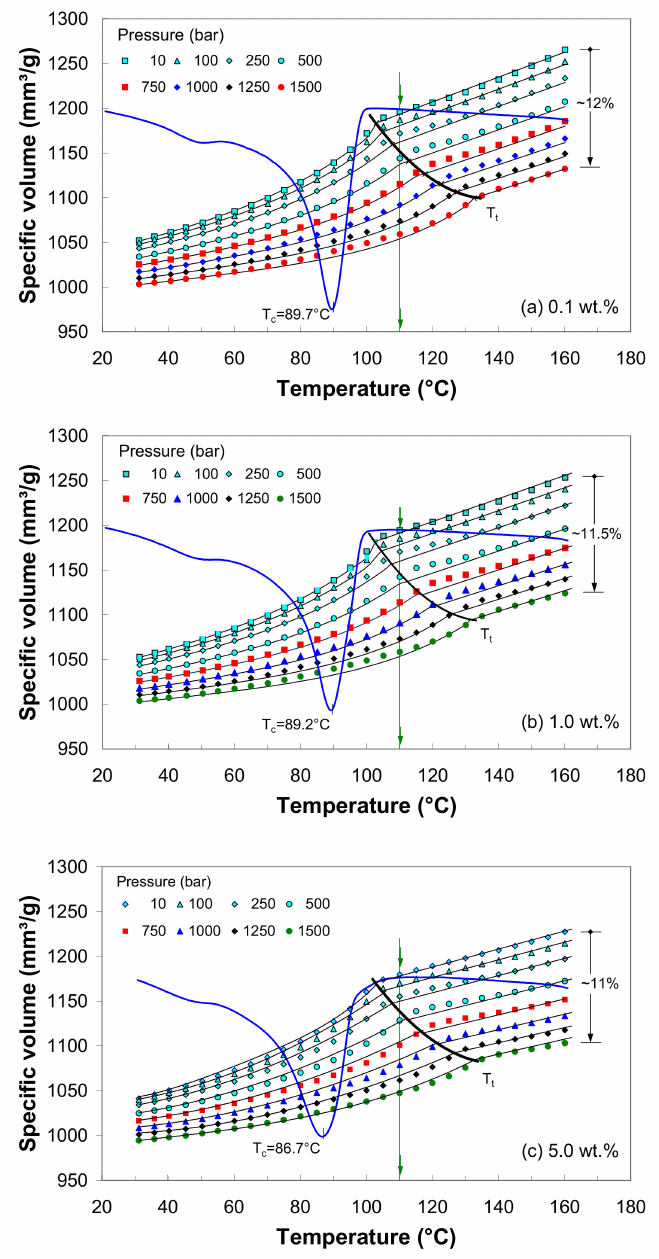
Figure 11. pVT diagram of the LDPE / MWCNT composite with ( a ) 0.1 wt.%, ( b ) 1 wt.% and ( c ) 5 wt.% of MWCNTs. The solid lines show data fitting to the Tait